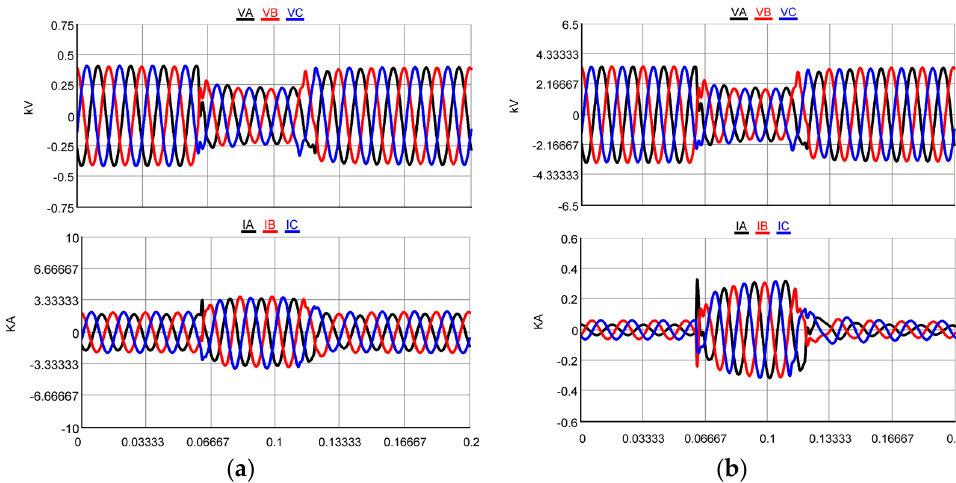
Figure 12. Three-phase fault applied at bus 7 in the transmission system of the testbed: ( a ) instantaneous voltage and current at bus 634; ( b ) instantaneous voltage and current at bus 680.